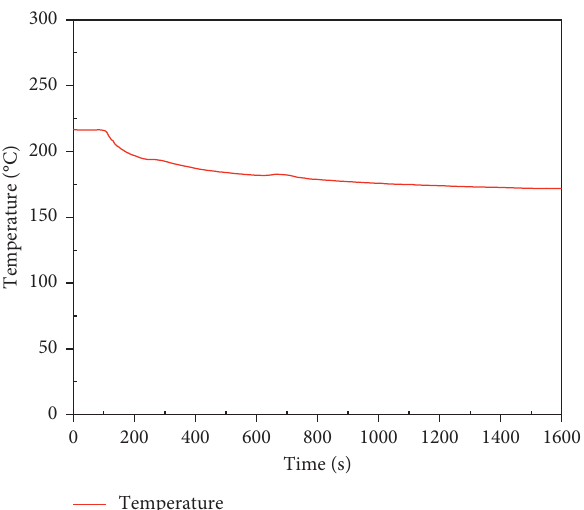
Figure 17: Temperature evolution at the deepest crack tip during the AOO